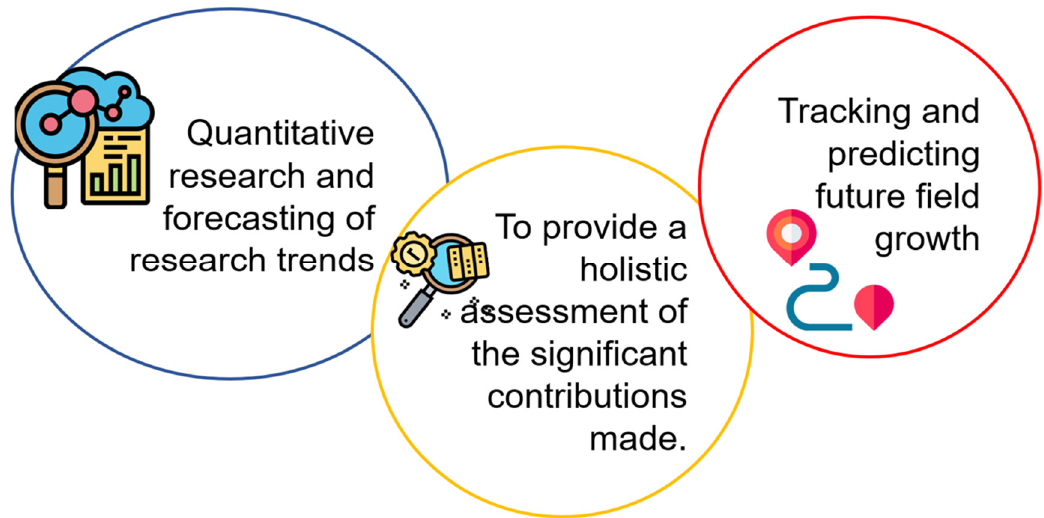
Figure 3. Time-lapse items.